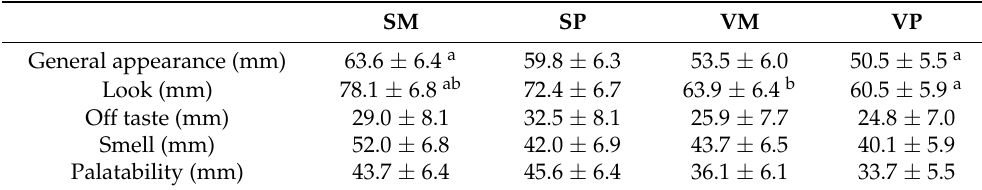
Table 5. Palatability evaluations of the four test meals 1